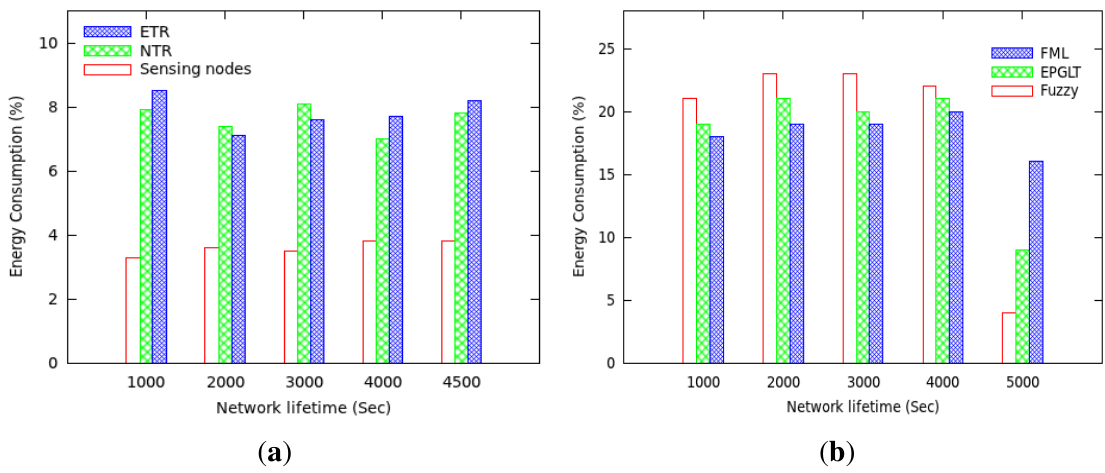
Figure 7. Network lifetime vs . energy consumption. ( a ) Energy consumption among nodes; ( b ) energy consumption in